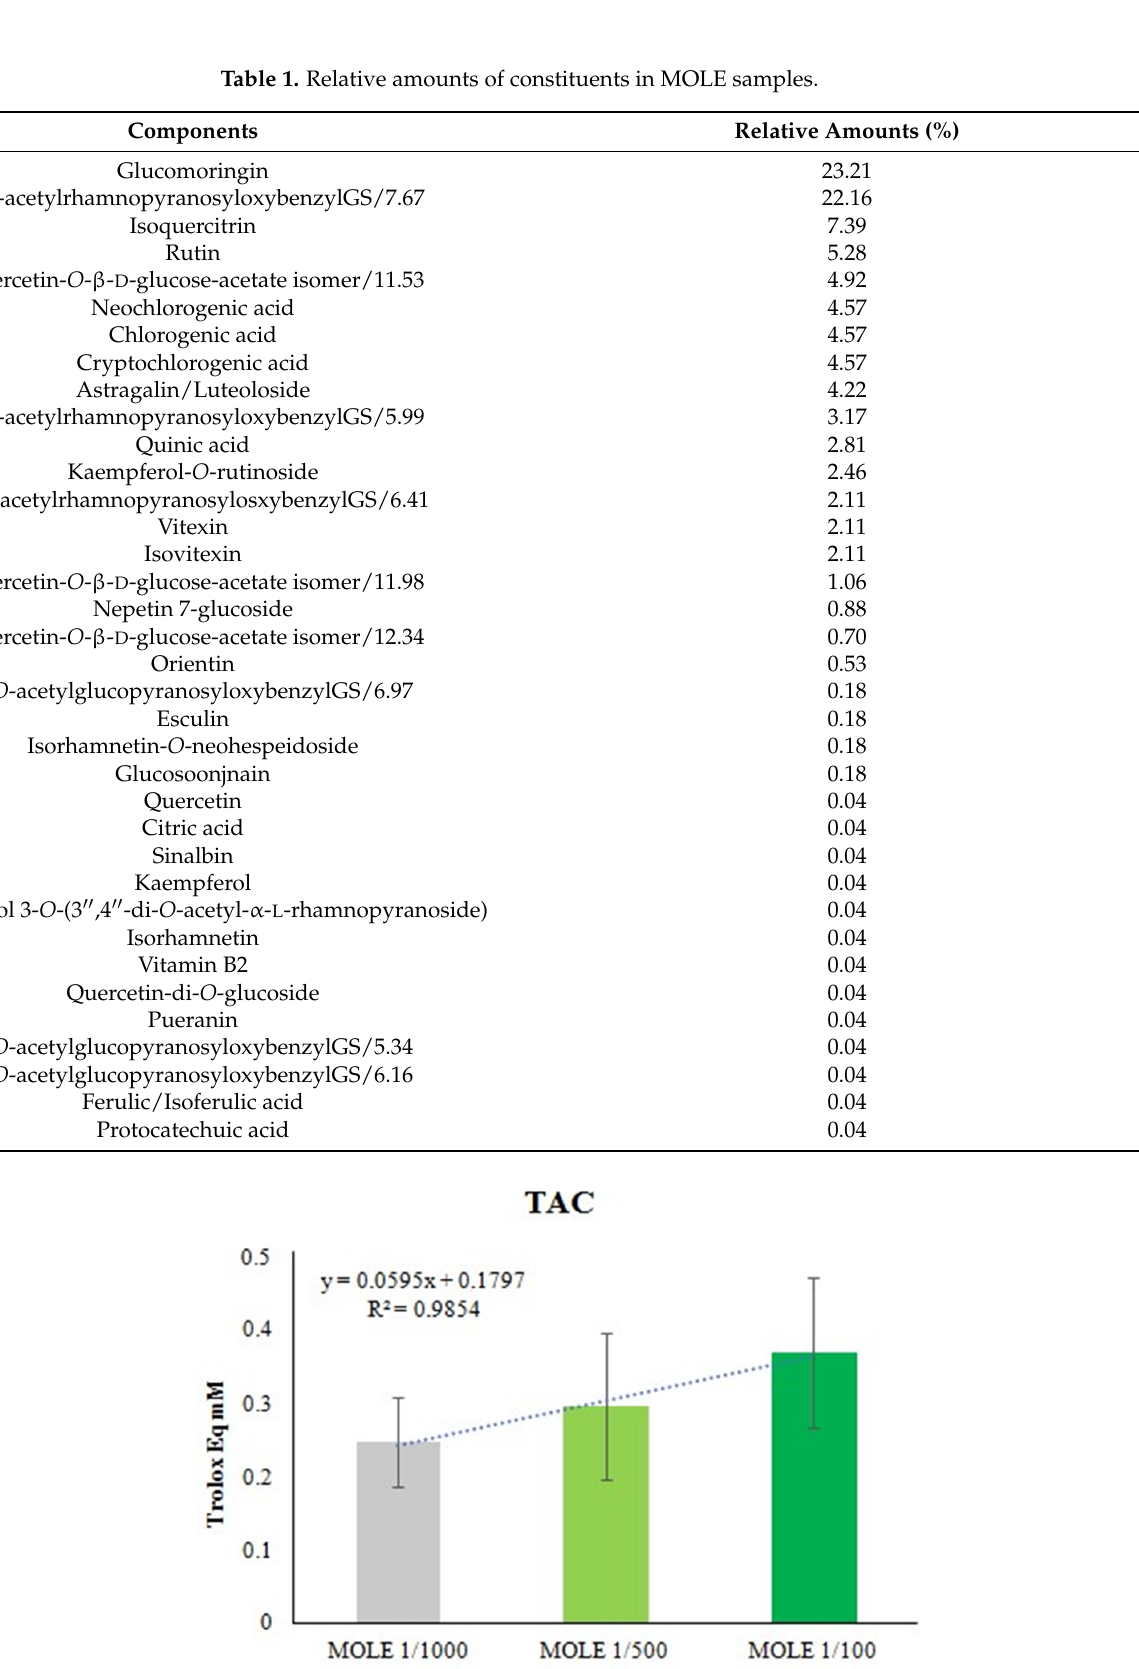
Figure 2. In vitro modified Trolox ® -equivalent antioxidant capacity assay of MOLE. MOLE stock solution dilutions (1/1000–1/500 and 1/100 working solution) were tested and the variation of absorbance was recorded and compared to those obtained using Trolox ® standards